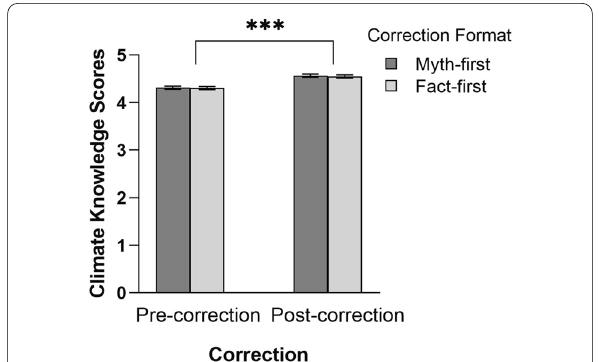
Table 1 Number of myths/facts and component order in